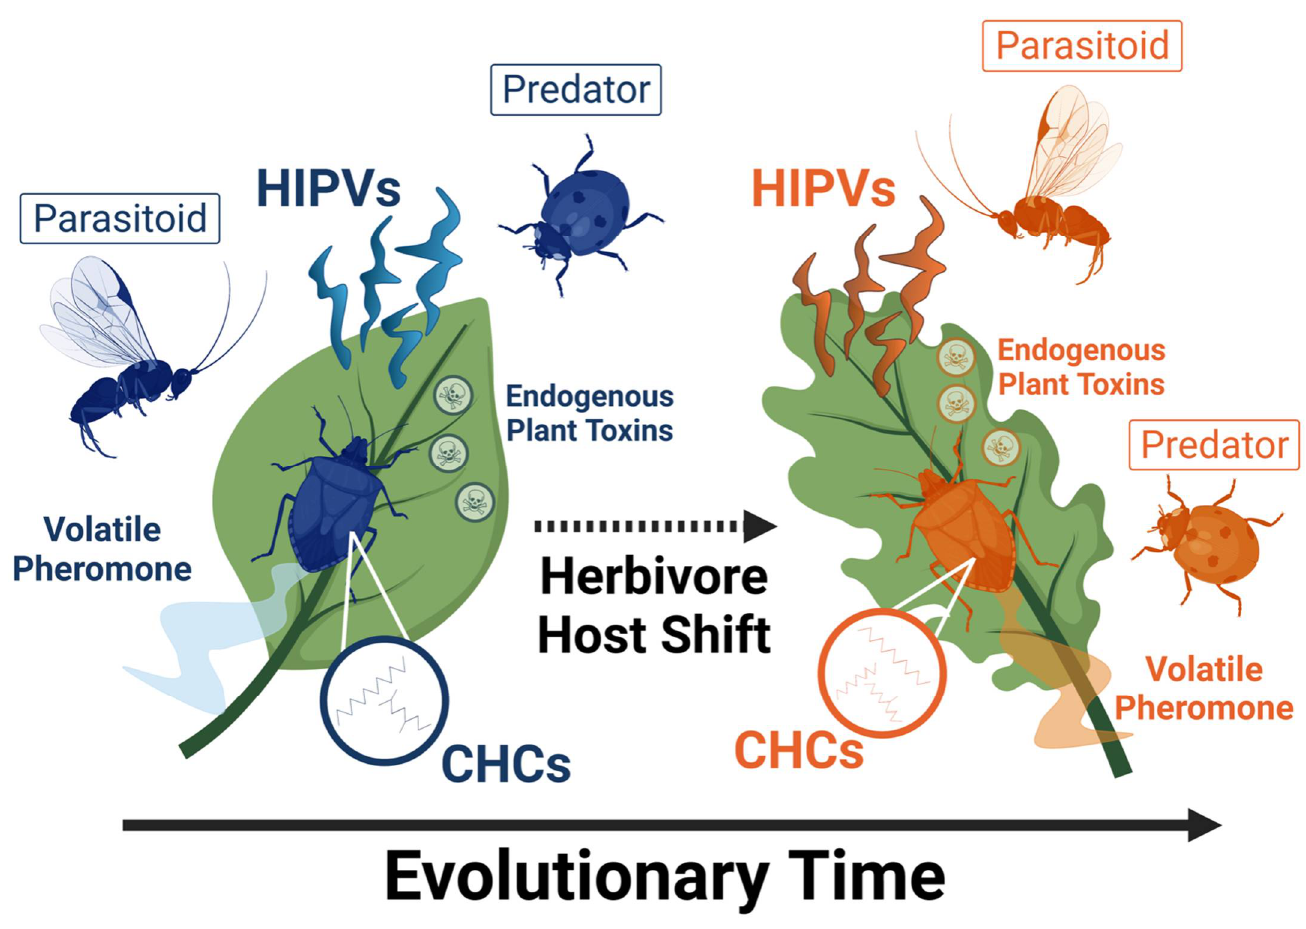
Figure 1. Conceptual model showing one possible evolutionary route to sequential radiation or natural enemy host-associated differentiation (HAD) following herbivore HAD. Populations of herbivores and natural enemies associating with different host-plant species represent genetically divergent populations within the same species of herbivore and natural enemy. HIPVs = herbivore- induced plant volatiles; CHCs = cuticular hydrocarbons. Figure generated using BioRender.